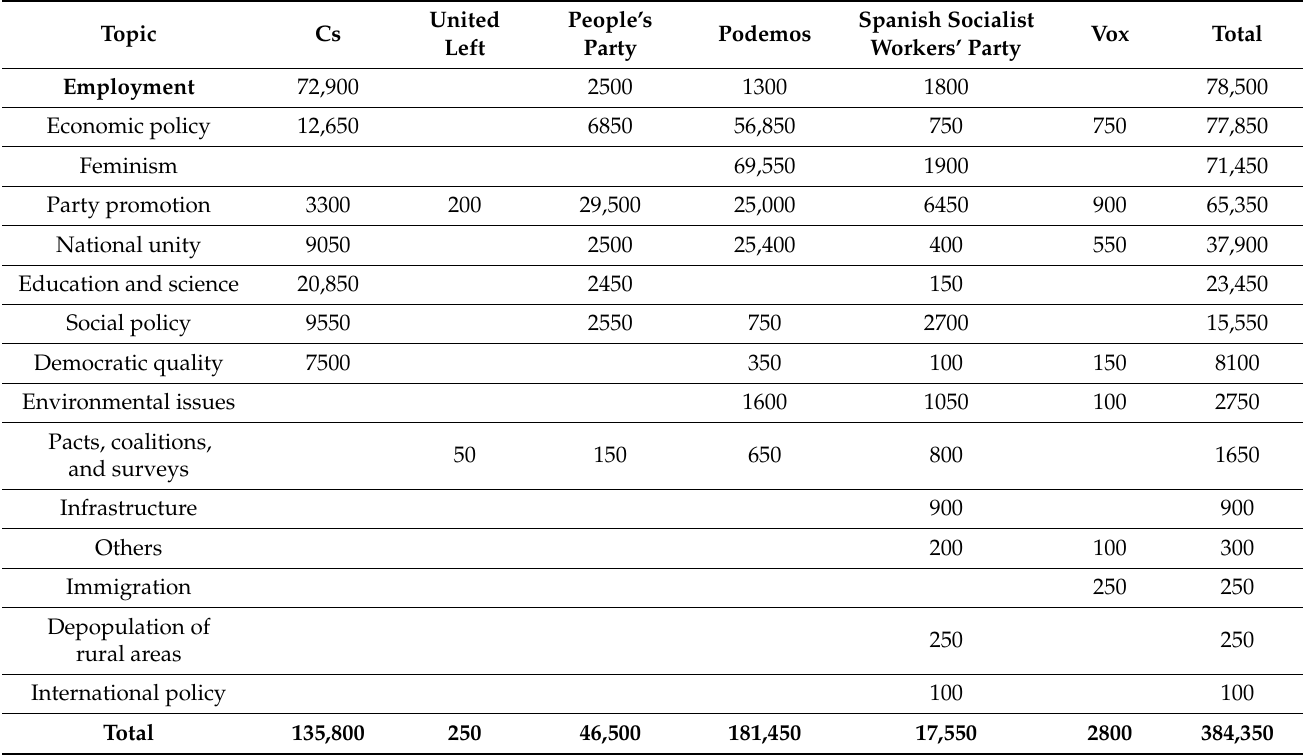
Table 5. Ad spend by topic and party in the November election campaign ( n = 4260). Source: Own